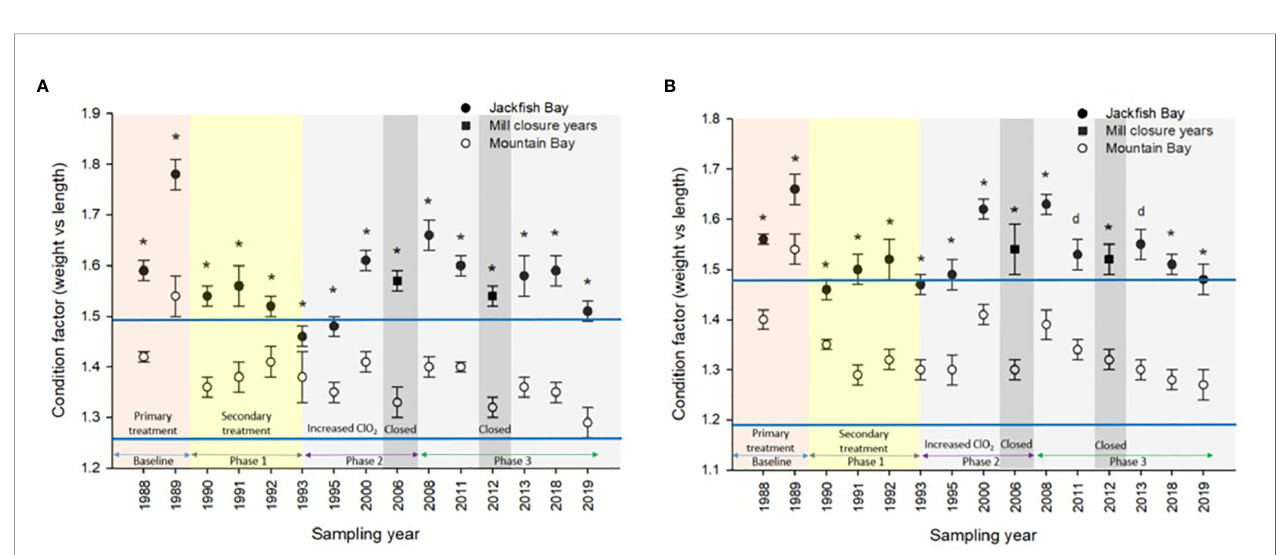
FIGURE 5 | Condition (± SE) of (A) female and (B) male white sucker ( Catostomus commersoni ) from Jack fi sh Bay and Mountain Bay, during the fall from 1988 to 2019. Asterisks* represent a signi fi cant difference (p ≤ 0.05) between sites within years, “ d ” represents an interaction between sites. All data before 2008 published in Bowron et al.